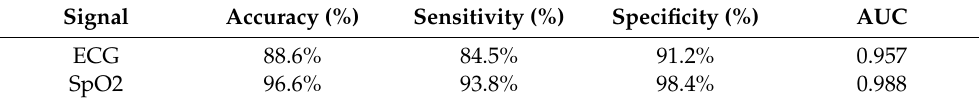
Table 5. Per-segment classification results based on RF classifier using either ECG or SpO2 feature